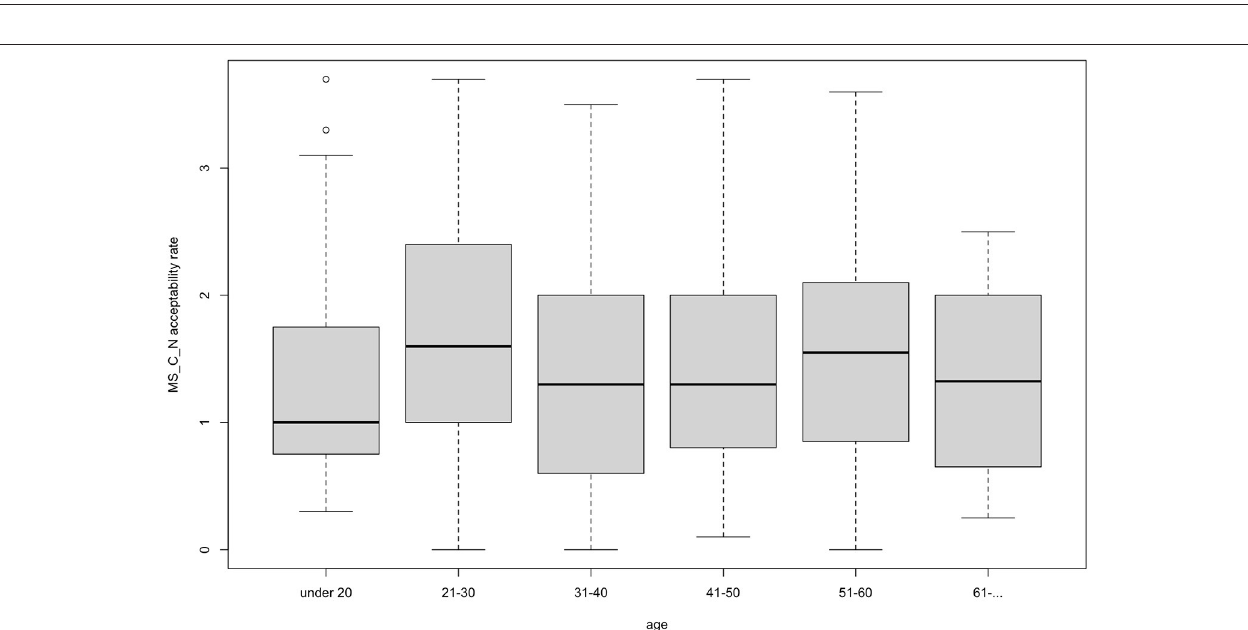
FIGURE 6 | Acceptability rate of deep -type in the non-agreement condition by